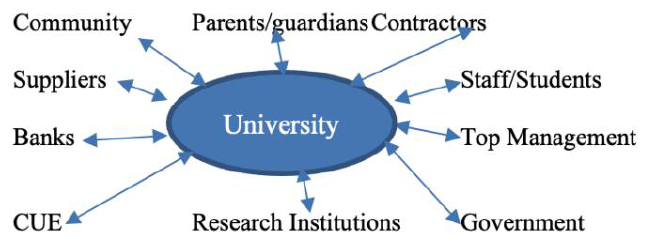
Figure 1 : University External and Internal Stakeholder’s Network; Source: Author